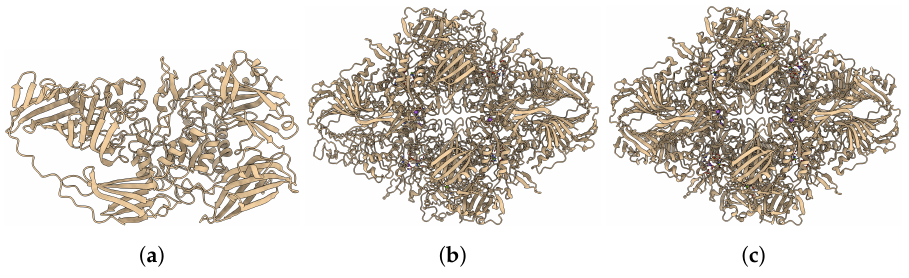
Figure A1. The target T201 is of EMD: 7770. ( a ) AlphaFold Predicted Structure. ( b ) DeepProLigand Predicted Structure. ( c ) PDB Deposited Structure with PDB ID: